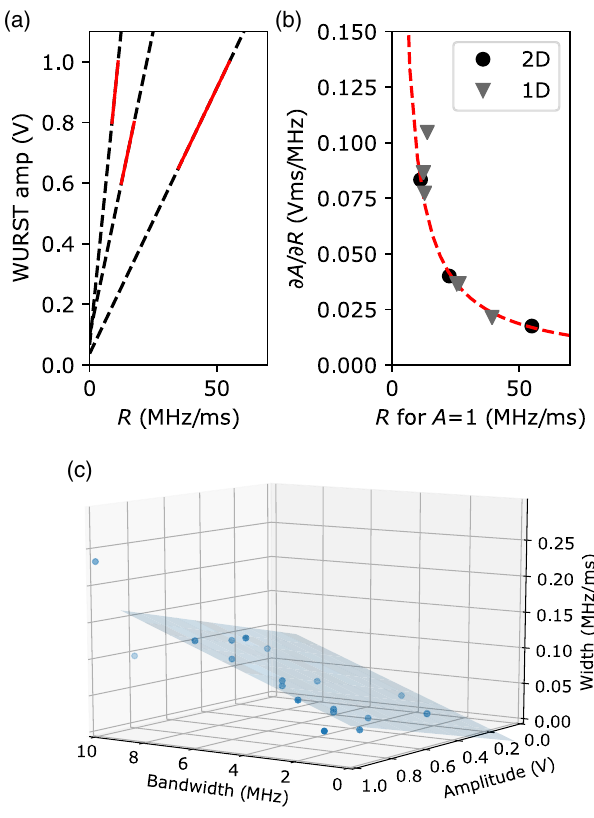
FIG. 14. (a) The line of strong echoes from 2D maps of AB -echo sequences. We fit a line to these data and extract their gradient. (b) The gradient of the lines fit in (a) as a function of their extrapolated bandwidth at amplitude A ¼ 1 (black circles). The same gradient measurement was also performed using finer 1D sweeps of bandwidth and amplitude values and plot on the same axes (gray triangles) showing good agreement. We fit these data with ∂ A= ∂ R ¼ C=R with C afit parameterandreturnthereddashed line and C ¼ 0 . 93 . (c) Width w of the line of equivalent WURST pulses as a function of WURST pulse parameters, defined as w ¼ Δ R sin θ where Δ R is the width in MHz/ms of the line of equivalent WURST pulses along the x axis in (a) and θ ¼ arctan ½ð ∂ A= ∂ R Þ = ð 1 V · ms = MHz Þ(cid:2) . We fit a planetothisdata toallow interpolationof the width as a function of bandwidth and